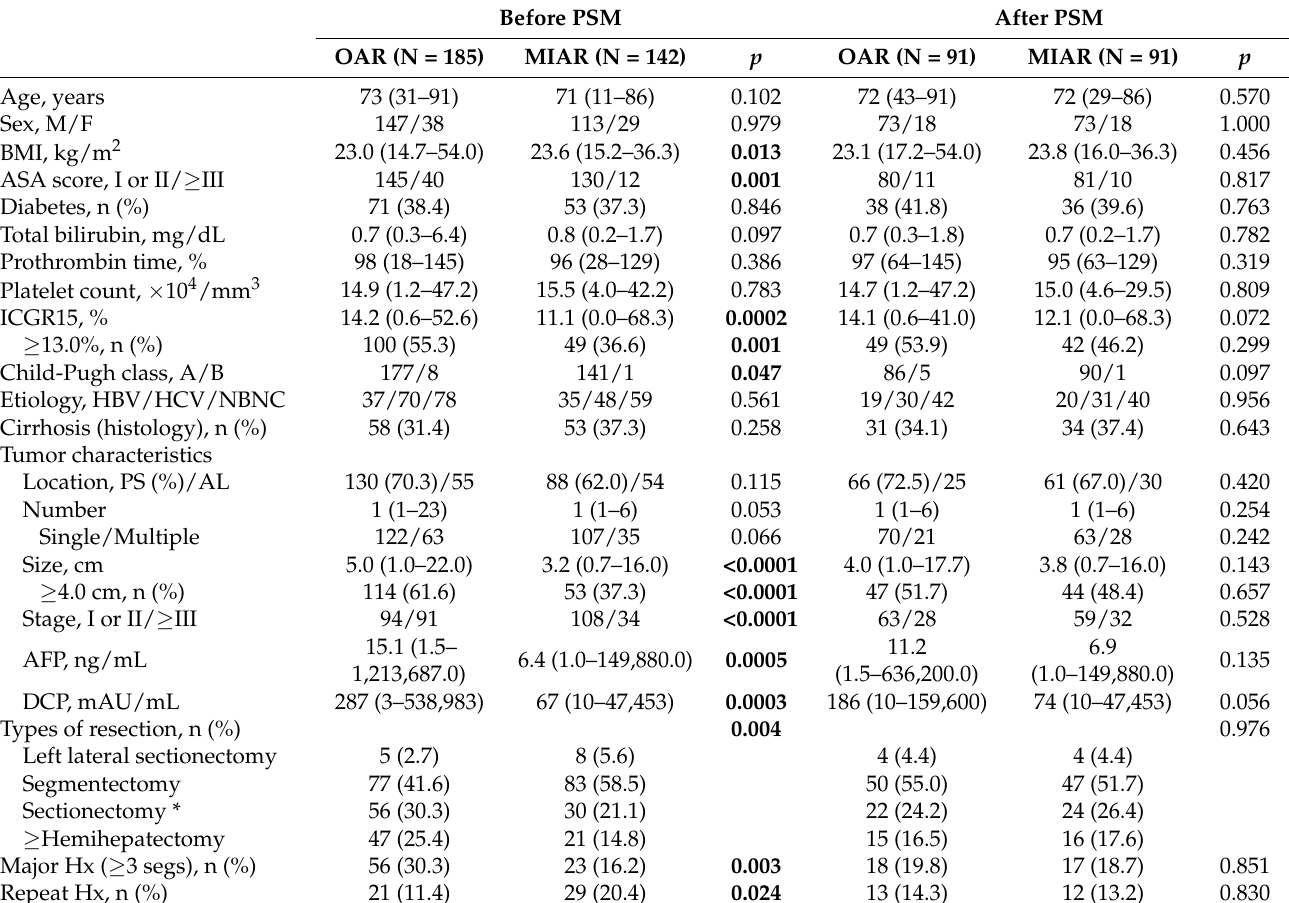
Table 1. Comparison of baseline data between open and minimally invasive AR for